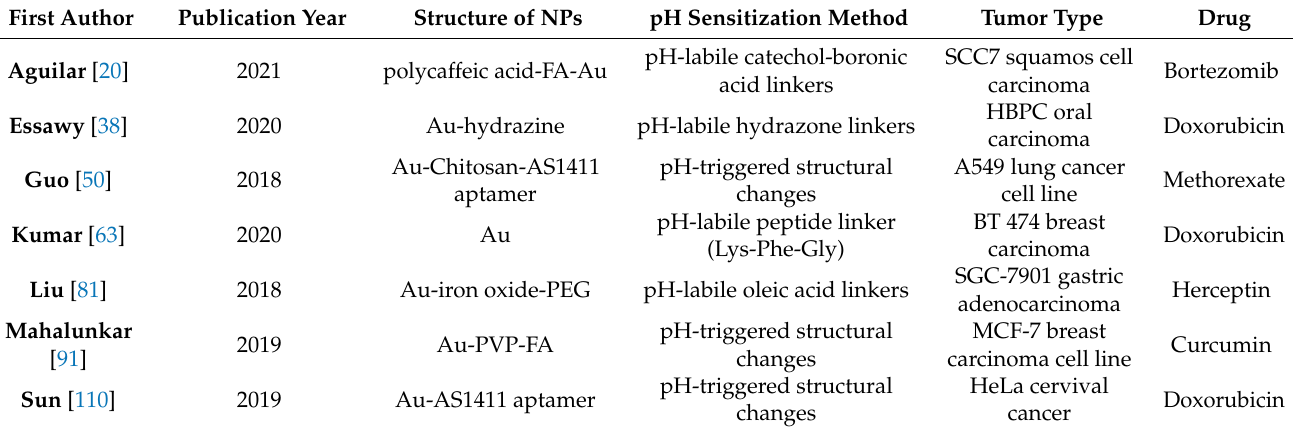
Table 5. Overview of gold NPs: structure, pH sensitization method, tumor type, and delivered